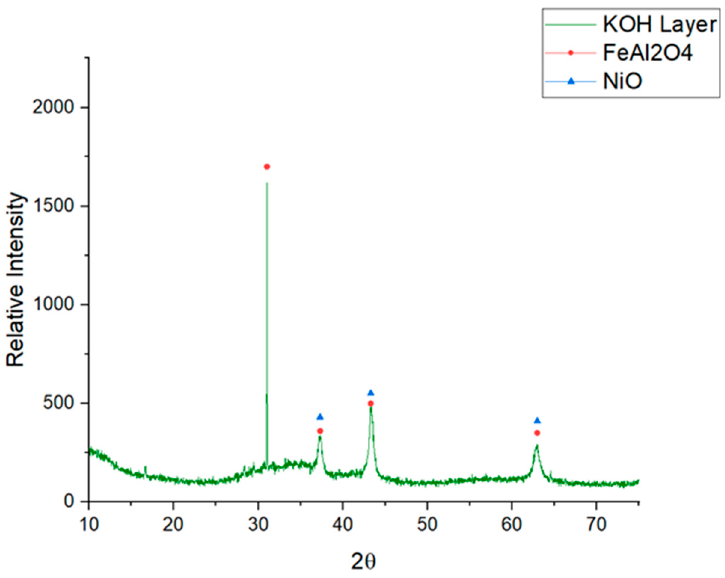
Figure 13. XRD obtained for the layer formed in OC4 alloy immersed in KOH. Table 4. Recommendation guide for corrosion rates CR in industry. Adapted from Ghali et al. [30]. mg/cm 2 mg/cm 2 yr.